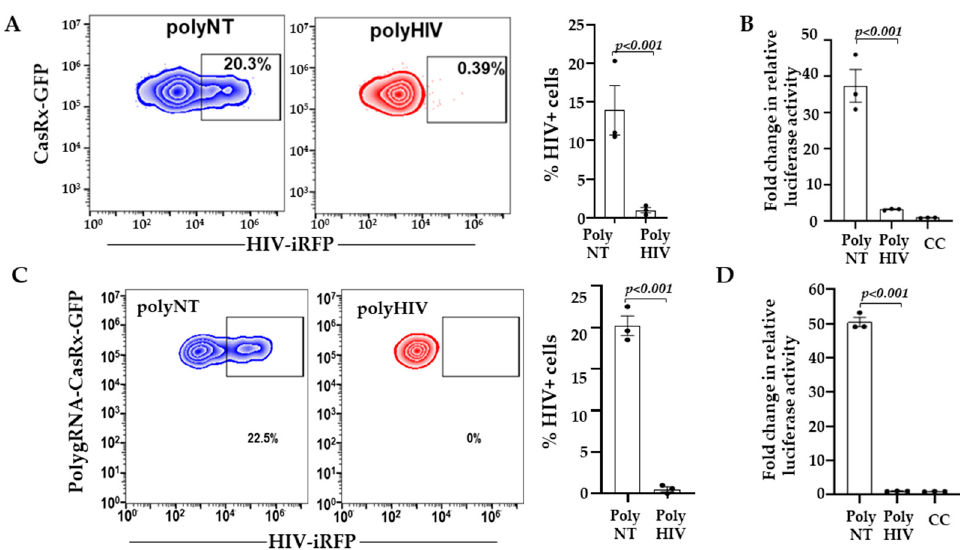
Figure 2. Inhibition of HIV-1 RNA by simultaneous targeting of distinct regions. ( A ) LRx cells were transfected with plasmid poly-gRNAs targeting HIV (polyHIV; red) or non-targeting control (polyNT) and HIV-iRFP. Forty-eight hours after transfection, expression of CasRx-GFP and HIV-iRFP were measured by flow cytometry; ( B ) supernatants collected from LRx cells transfected with HIV-iRFP and polyHIV or polyNT plasmids were added to the reporter cell line TZM-bl containing luciferase gene under HIV-LTR. Relative luciferase expression was measured after 48 h and presented as a fold change in relative luciferase activity normalized to cells only control (CC); ( C ) Lenti-X TM cells with stable expression of CasRx-polyNT (blue) or CasRx-polyHIV (red) were transfected with HIV-iRFP. Forty-eight hours after transfection, expression of CasRx-GFP and HIV-iRFP were measured by flow cytometry; ( D ) supernatants collected from HIV-infected CasRx-polyHIV and CasRx-polyNT cells were added to the reporter cell line TZM-bl containing luciferase gene under HIV-LTR. Relative luciferase expression was measured after 48 h and presented as a fold change in relative luciferase activity normalized to cells only control (CC). The means ± s.e.m. are depicted as horizontal and vertical bars for each group, respectively. The Student’s t-test was used for statistical comparisons, and two-tailed p values are indicated.